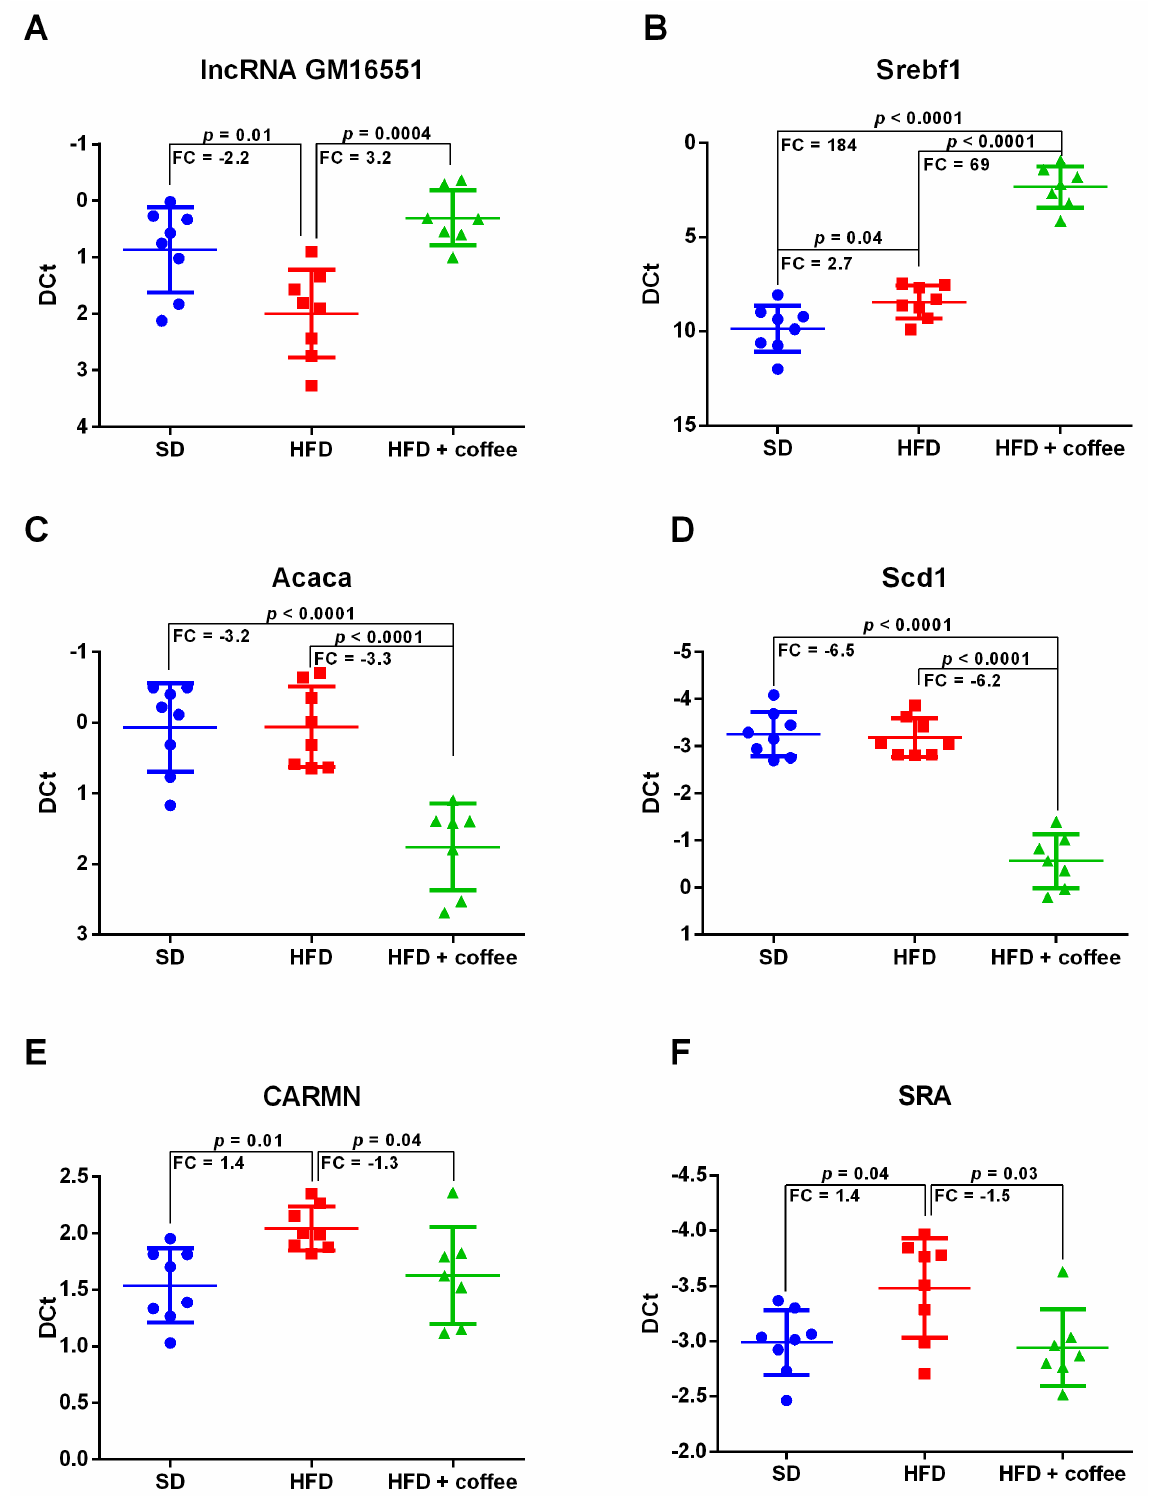
Figure 2. Dot plots of the hepatic expression of Gm16551 lncRNA (Panel A ), sterol regulatory element-binding protein factor 1 (Srebf1) mRNA (Panel B ), acetyl coenzyme A carboxylase alpha (Acaca) mRNA (Panel C ), stearoyl coenzyme A desaturase 1 (Scd1) mRNA (Panel D ), cardiac mesoderm enhancer-associated (CARMN) lncRNA (Panel E ) and steroid receptor RNA activator (SRA) lncRNA (Panel F ), analyzed through qPCR, in mice fed standard diet (SD), high fat diet (HFD) and HFD plus decaffeinated coffee; n = 23: 8 SD, 8 HFD, 7 HFD + coffee. Transcript statistical significance of DE transcripts was evaluated with one-way ANOVA with Tukey post-hoc test for multiple comparisons (two-tailed p -value < 0.05); FC = fold